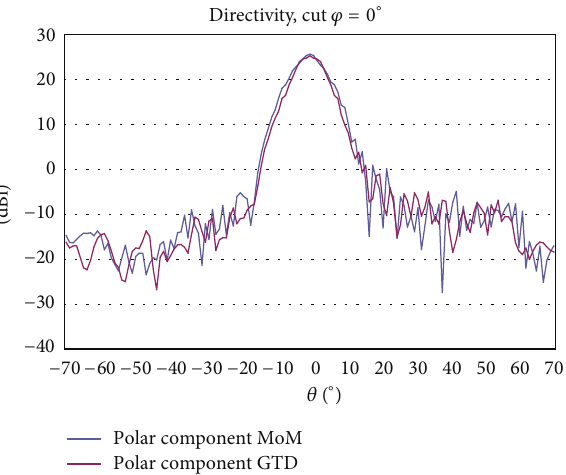
Figure 28: Single reflector with an obstacle and the observation surface.